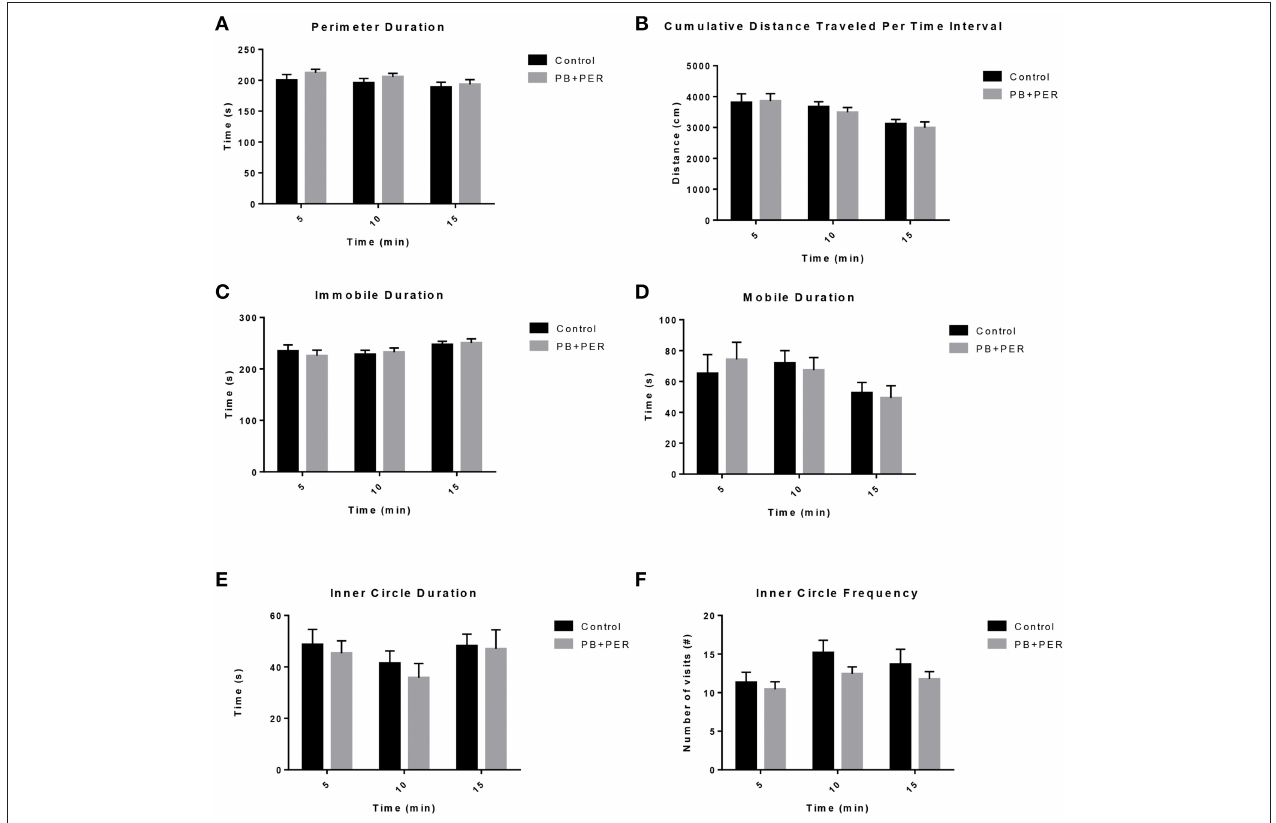
FIGURE 1 | No locomotor impairment and anxiety-like behaviors were observed at 11 days-post acute exposure to PB + PER. (A) Perimeter Duration (s), (B) Cumulative Distance Traveled Per Time Interval (cm), (C) Immobile Duration (s), (D) Mobile Duration (s), (E) Inner Circle Duration (s), and (F) Inner Circle Frequency (#) were examined for exposed and control mice during the Open Field